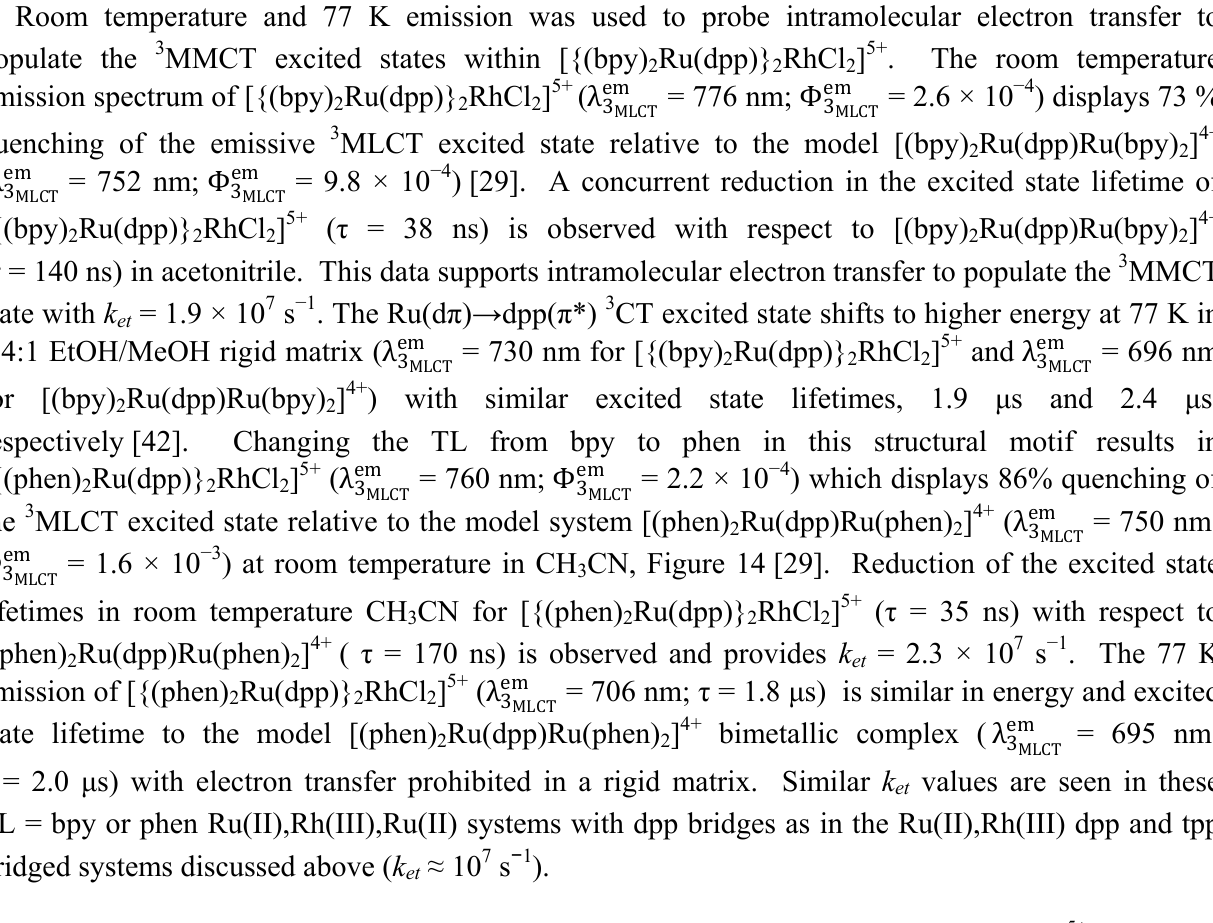
Ru(dpp)} RhCl ] 5+ ( ― ) 2 2 2 Ru(dpp)Ru(phen) ] 4+ model ( ― ) at room temperature in 2 2